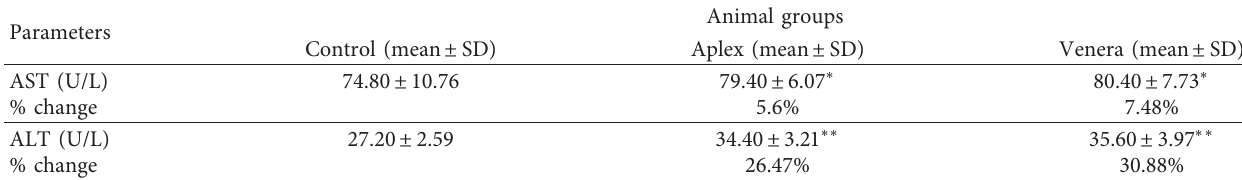
Table 3: Liver function enzymes in sera of control and treated animal groups.